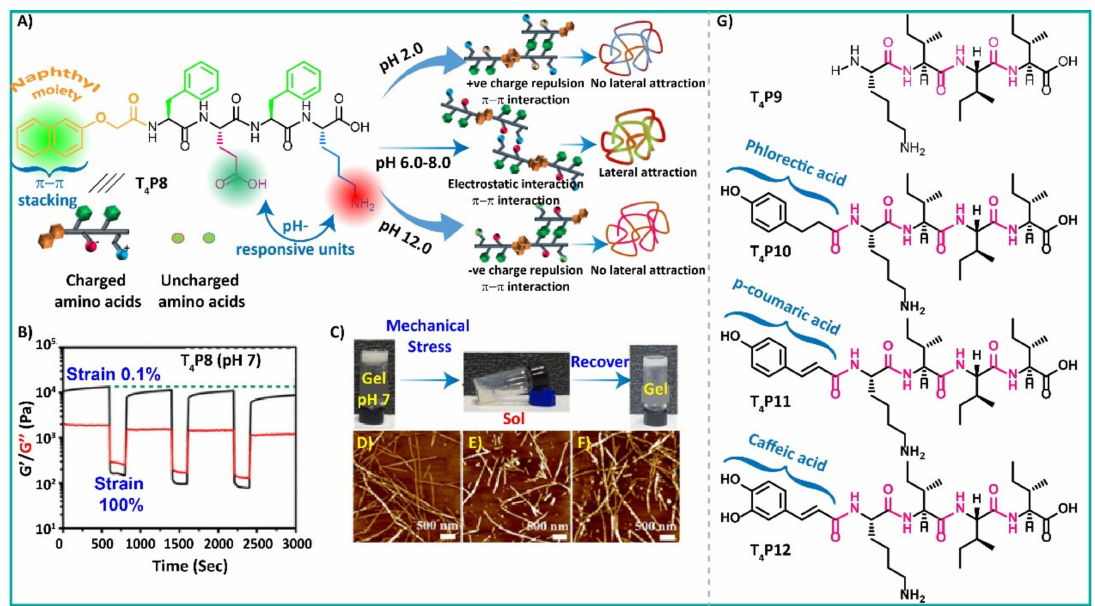
Figure 13. ( A ) Chemical structure of the tetrapeptide hydrogelator (T 4 P8) and possible self-assembly schematic illustration showing formation of different nanoarchitectures at different pH. ( B ) Thixotropy test of the tetrapeptide hydrogel at pH 7.0. ( C ) Stimuli-responsive gel-sol-gel transition of T4P8. ( D – F ) AFM images of the stimuli-responsive gel-sol-gel state; reproduced with permission from Ref. [125]. Copyright (2020) American Chemical Society. ( G ) Molecular structure of the tetrapeptide hydrogelators. The structures were redrawn from Ref.